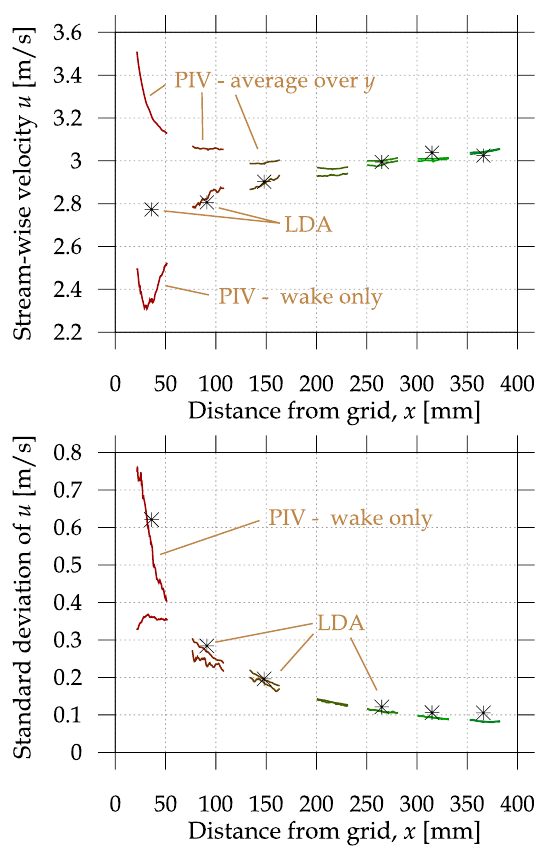
Fig. 4. Turbulent kinetic energy as a function of the distance from the grid for Reynolds number 3 . 1 · 10 3 . The plotted value is averaged over the span-wise coordinate ( y ). There are displayed powers of the dotted lines just under the data (solid lines). Note the log-log plot.